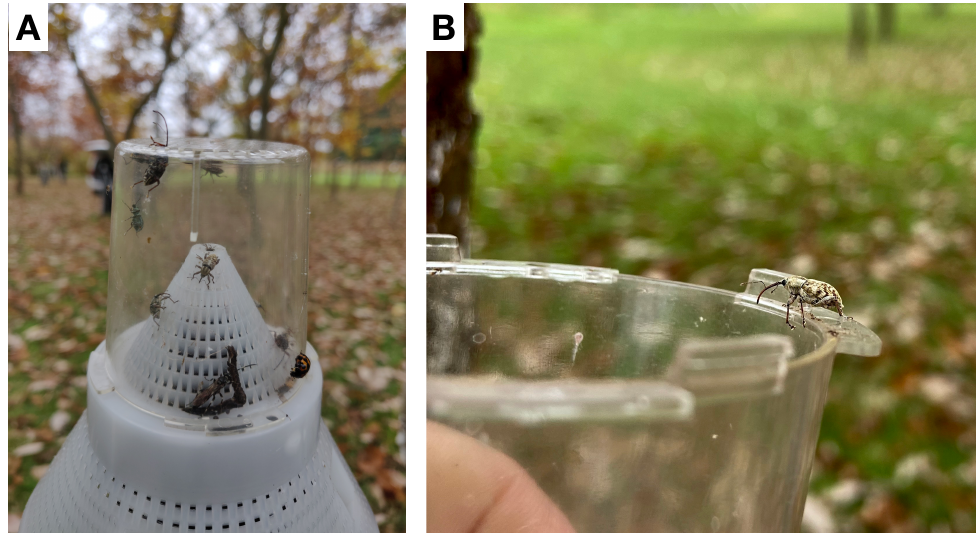
Figure 6. Adult lesser chestnut weevils ( C. sayi ) were collected in trunk and pyramid traps using a conical plastic mesh that terminated in a clear plastic cup perforated at the end. ( A ) Many adult C. sayi were eager to escape. Note rostrum of adult female C. sayi extending above the trap. ( B ) Some C. sayi adults preferred to hang